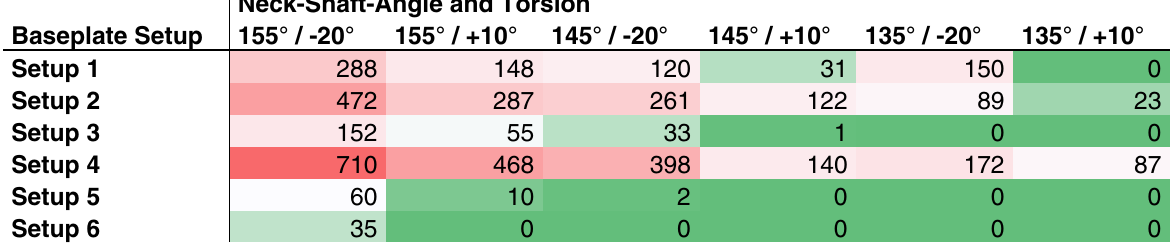
Table 3 Impingement volume in the final position of 40° of extension and 60° of internal rotation Neck-Shaft-Angle and